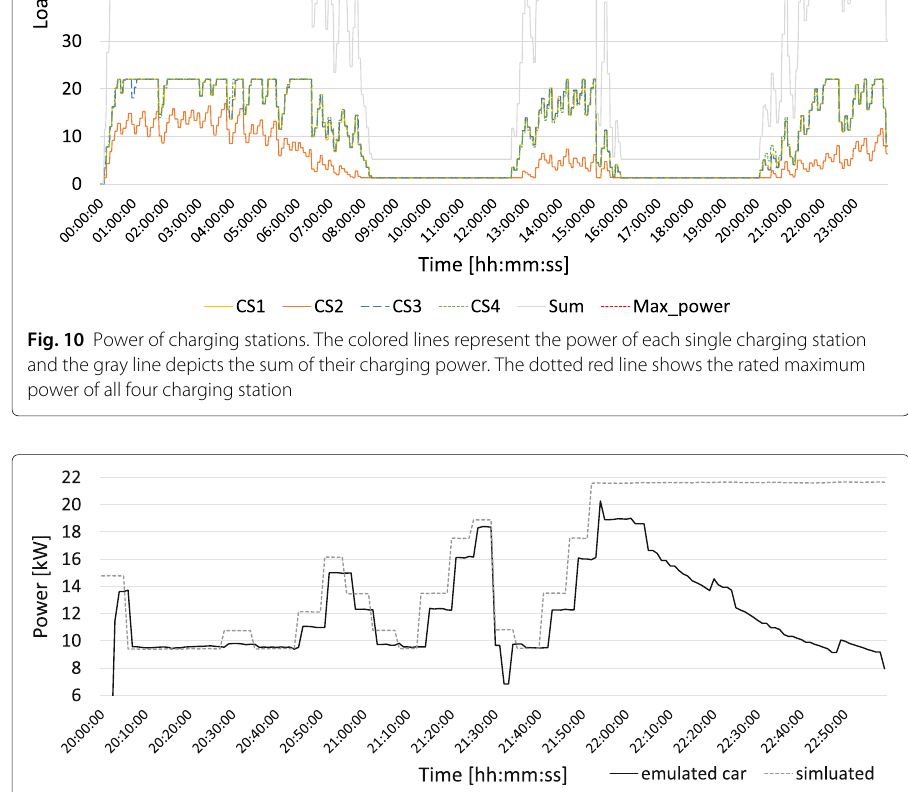
Fig. 11 Comparison of the simulated charging signal with the reaction of an emulated car. At the end of the charging process the emulated car reaches its saturation phase and reduces its charging power gradually